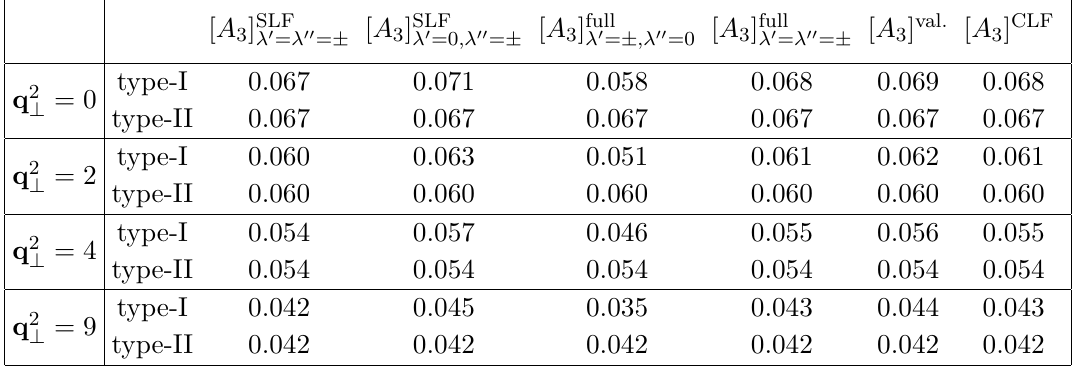
Table 3 . Numerical results of form factor A 3 ( q 2 See text for further